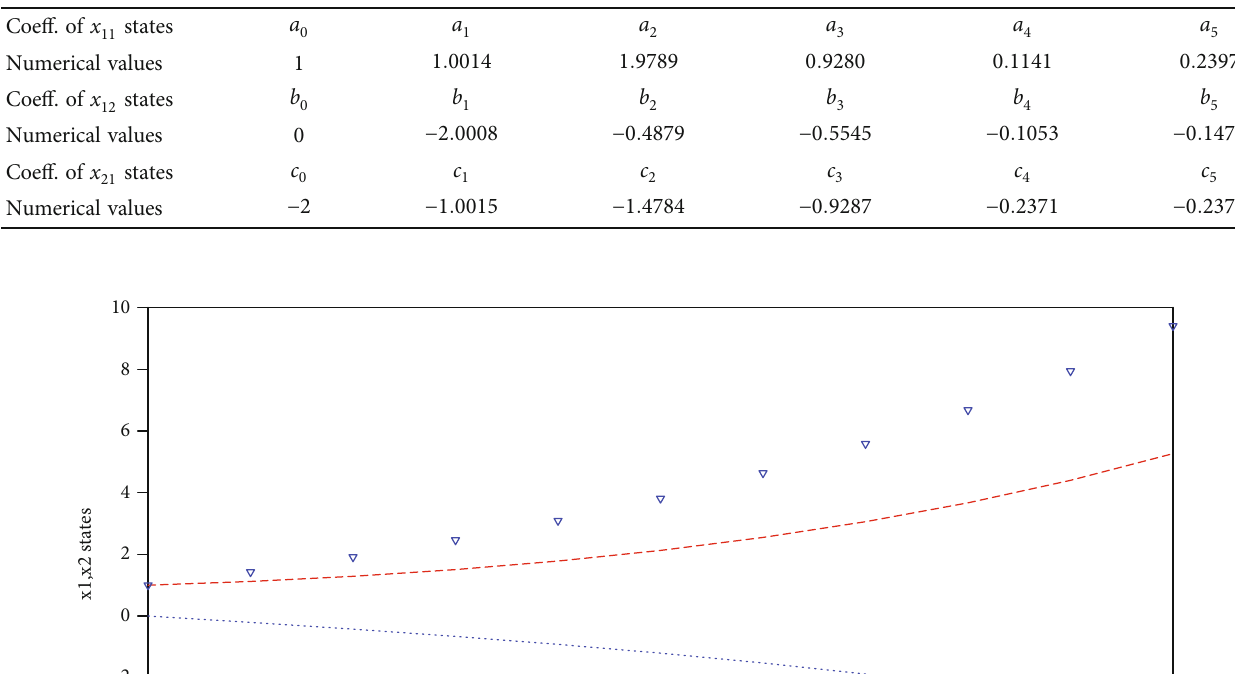
Table 4: Numerical coe ffi cients of solutions x